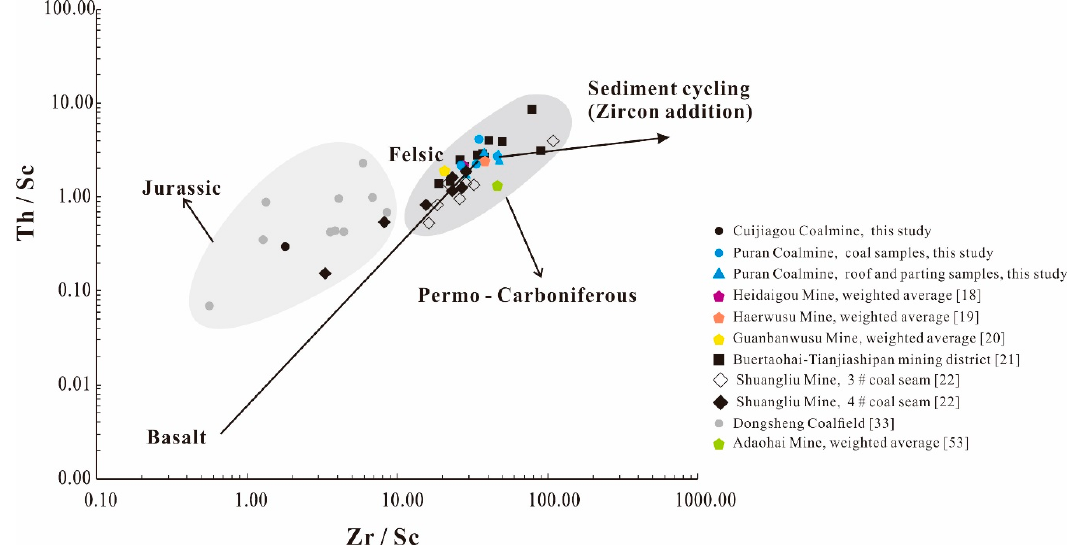
Figure 16. Th / Sc-Zr / Sc cross-correlation plot for the Cuijiagou and Puran coals as well as partings and roof, comparing with the Junger and Daqingshan coals.